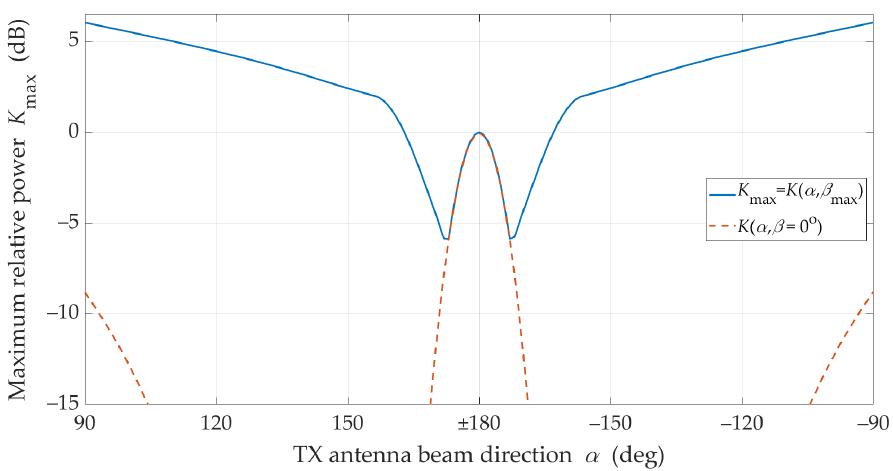
Figure 8. Compensation effectiveness for beam misalignment under NLOS conditions.